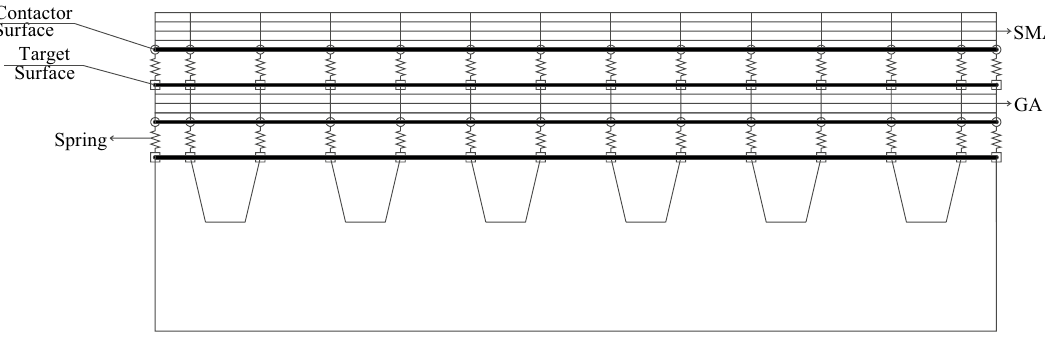
Figure 4. Schematic of interlayer contact bonding model (Not to